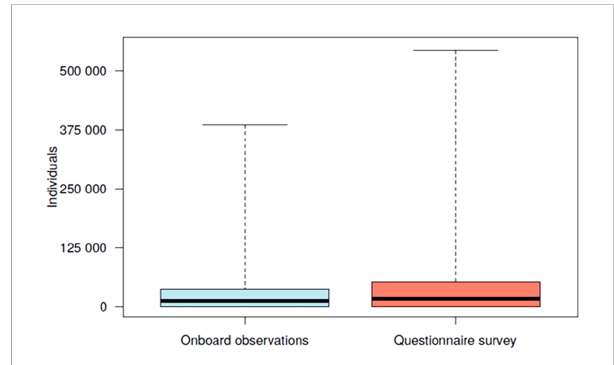
FIGURE 9 Estimates of annual bycatch of the harbour porpoise by Black Sea fl eet involved in turbot fi shery. Median values are shown as bold lines, and interquartile ranges are shown as